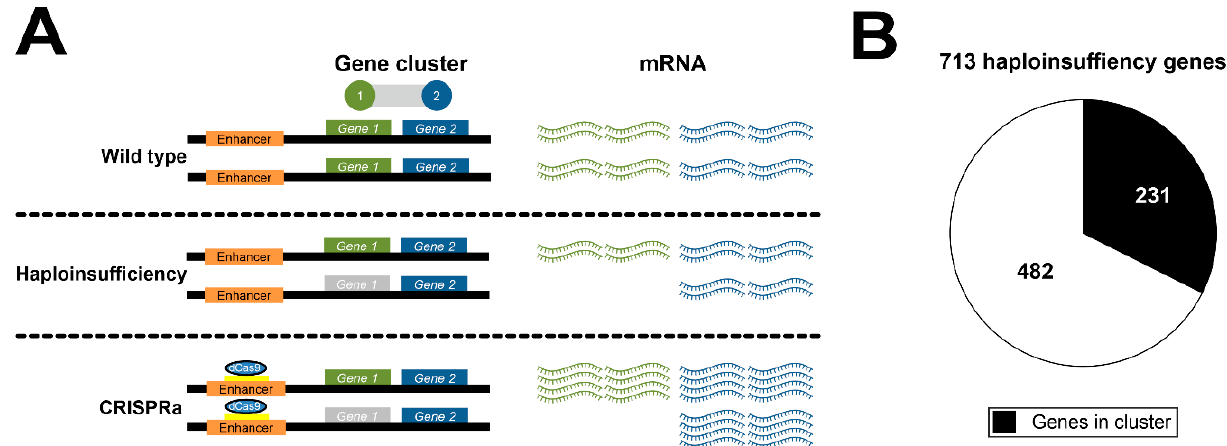
Figure 5. The potential role of gene expression regulation cluster in gene therapy. ( A ) Schematic overview of a gene therapy approach modifying expression of a gene, whose disease-associated deletion causes a haploinsufficiency phenotype. In the regular situation, gene 1 (green) and gene 2 (blue) are expressed but are known to be regulated by the same genetic signal (gene cluster). The disease-associated deletion of one copy of gene 1 is leading to haploinsufficiency. A planned gene therapy—e.g., CRISPR/Cas-mediated activation (CRIPSRa)—is intended to enhance expression of the regular copy of gene 1 to ameliorate the disease phenotype. This procedure potentially also increases gene 2 expression as the latter gene is part of a common regulatory gene cluster with gene 1. Gene 2 is therefore a potential off-target, which is currently not considered by common off-target prediction approaches. ( B ) Occurrence of haploinsufficiency genes in gene expression regulation clusters as defined in this study. Of 713 genes known for causing haploinsufficiency-related phenotypes, 231 (32.4%) were found to be part of gene expression regulation clusters.